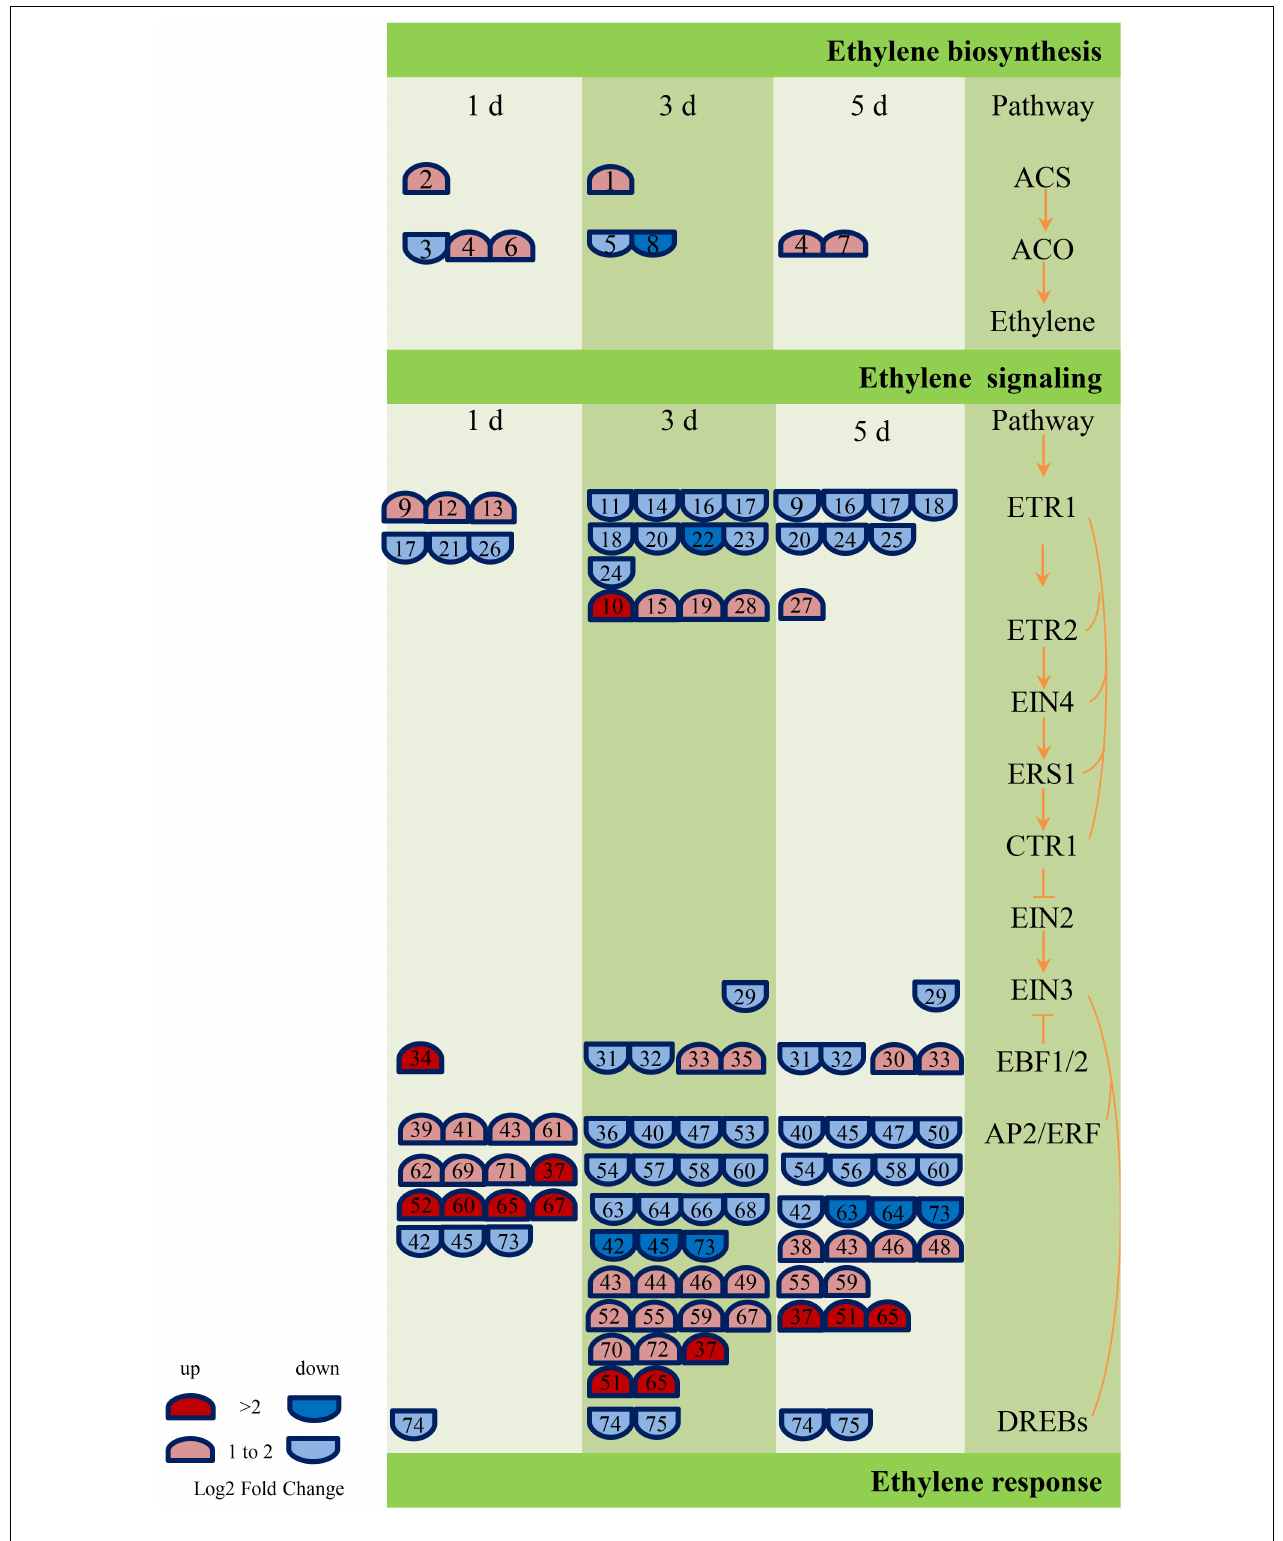
FIGURE 8 | Ethylene biosynthesis and signaling-related genes responses to GXS16 colonization in sugarcane roots. Gene expression levels (log2 fold change) are represented as colors and symbols. Red stands for upregulated and blue stands for downregulated genes. The DEGs are identified with numbers which are illustrated in Supplementary Table 5